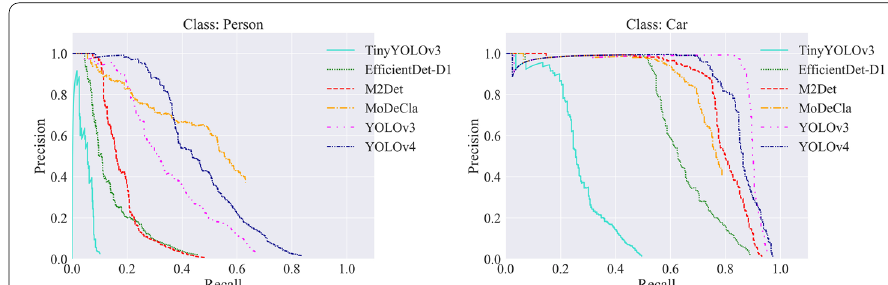
Fig. 7 Cluster precision-recall curves for the detectors on the Summer benchmark